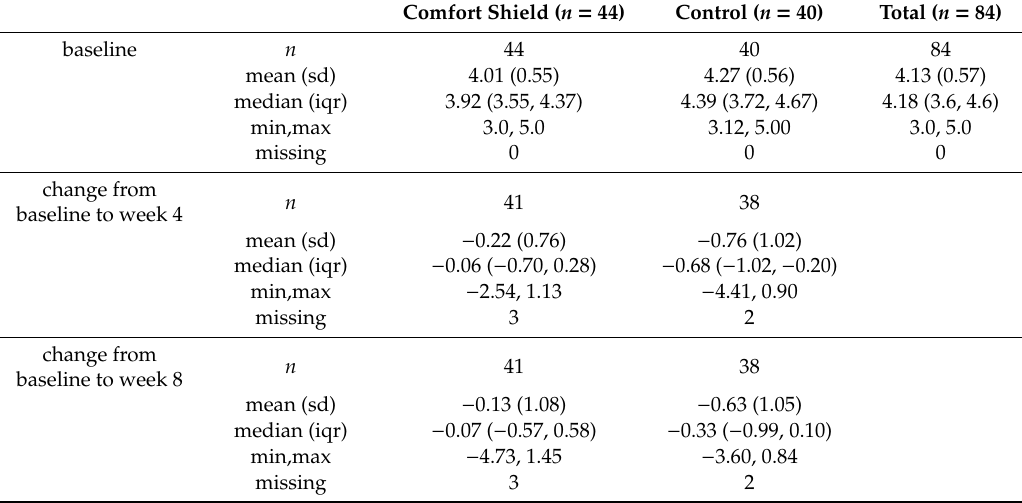
Table 4. CFS: Value at baseline and change from baseline to each post-baseline visit—PPS ( n = 84)—Descriptive analysis, by